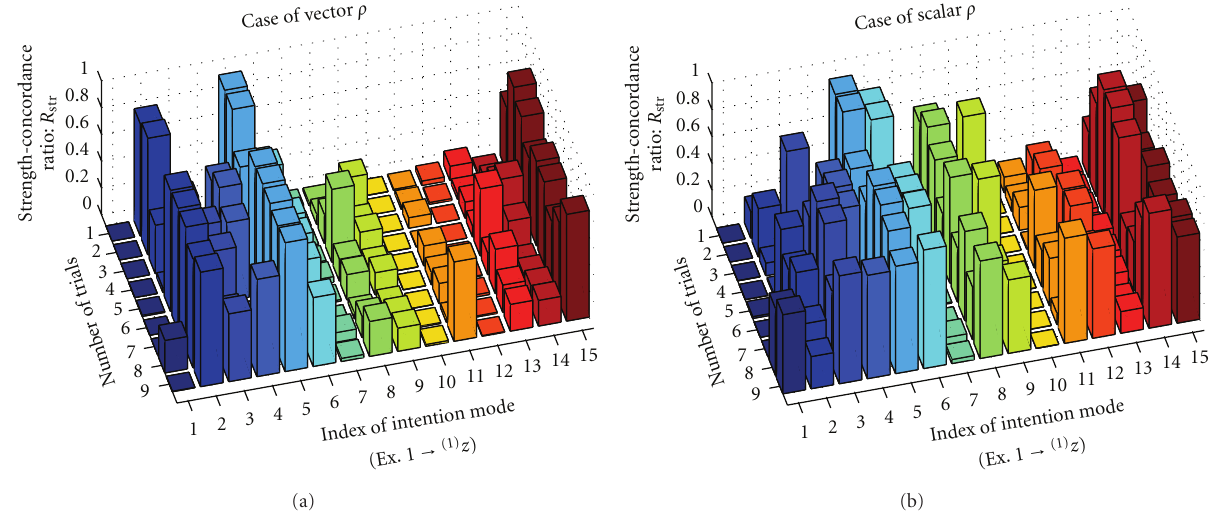
Figure 14: Comparison of strength-concordance ratios R str in two cases: results using vector ρ (a) and scalar ρ